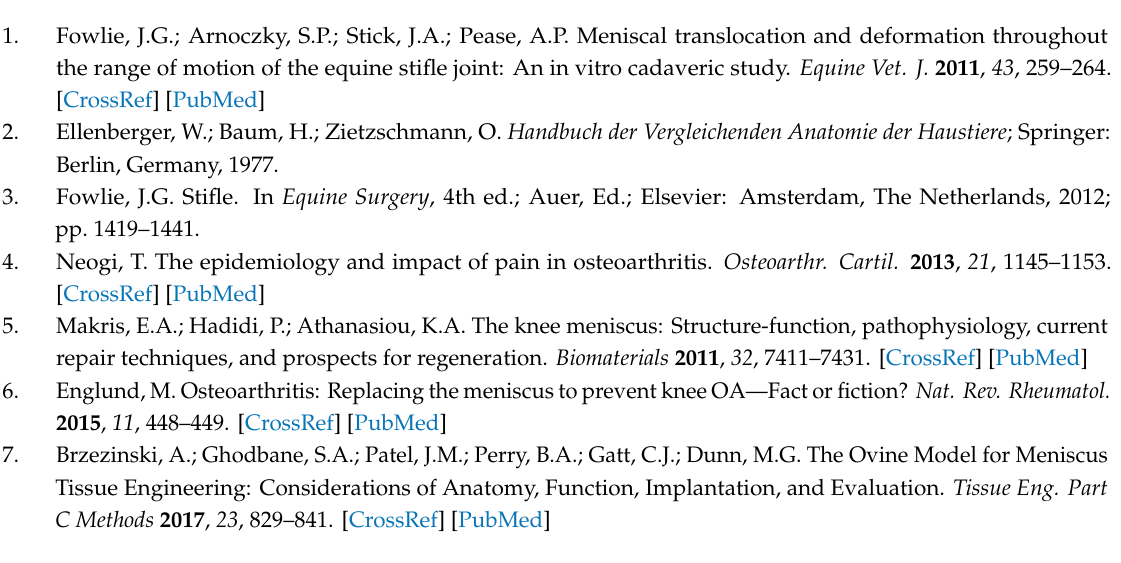
Figure S1: Image processing and manual segmentation of the menisci. Summary of FE modelling parameters: Table S1: Summary of number of elements of all objects used in FEA, Formula S1: Material properties used for